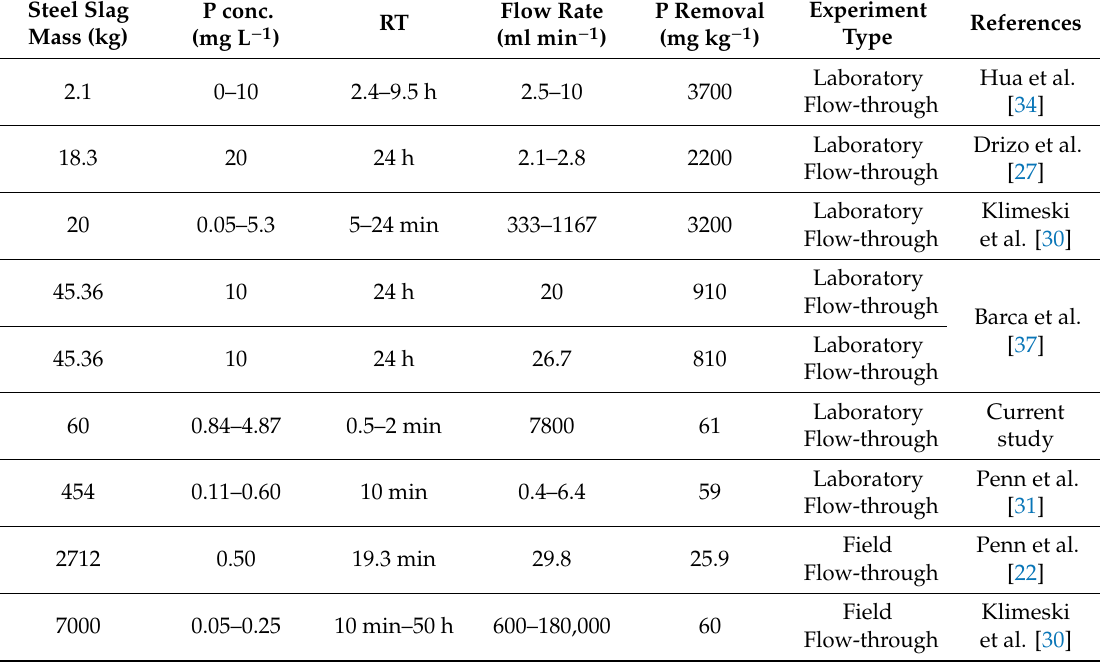
Figure 6. Predicted and measured total phosphorus (P) removal (TP rem ) as a function of total P added to the slag, expressed as a function of slag mass ( a ) and as a percentage ( b ). Table 3. Summary of phosphorus (P) removal by slag, among several studies conducted under a variety of experimental